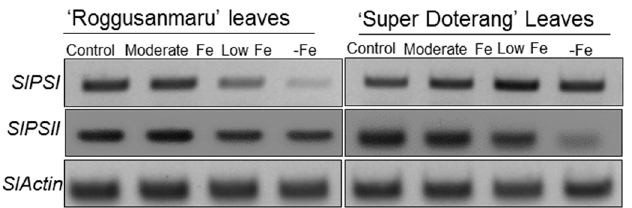
Figure 7. Semi-quantitative RT-PCR analysis of SlPSI and SlPSII in leaves of “Roggusanmaru” and “Super Doterang” tomato cultivar ( SlActin acted as a normalized housekeeping gene). Plants were grown under Fe-sufficient (control); moderate Fe; low Fe; and Fe-deficient (–Fe) Hoagland nutrient medium for 10 days.